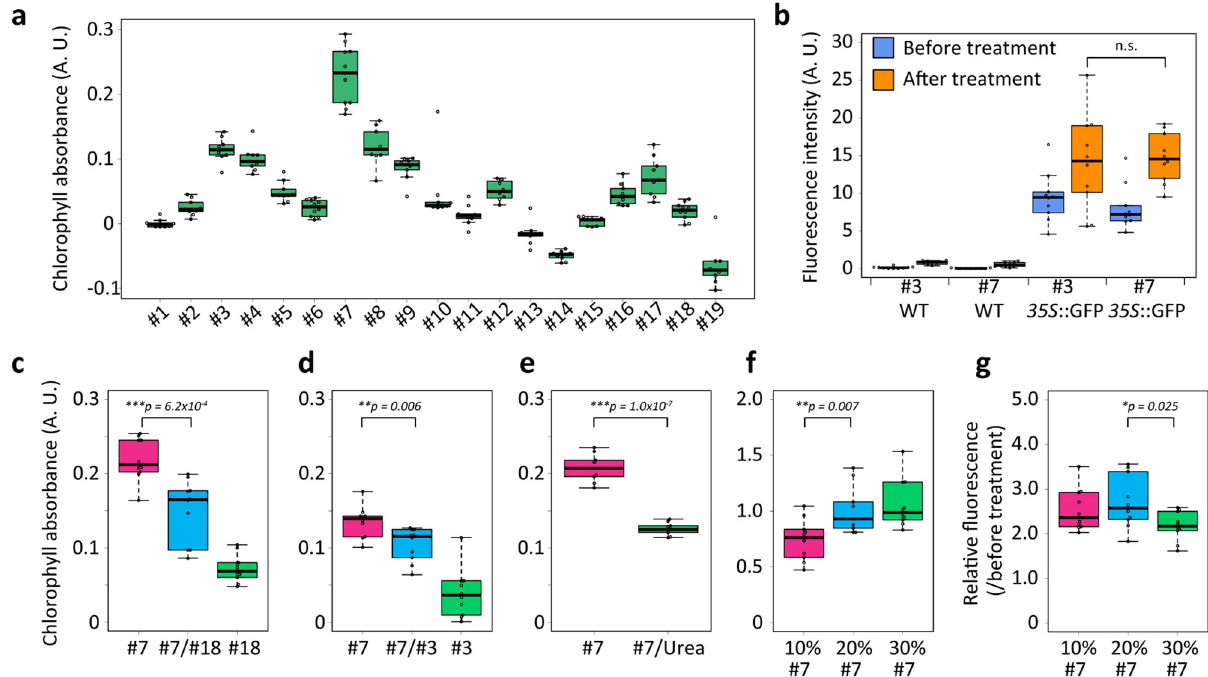
Fig. 1 Consideration of decolorization conditions. a Two-week-old plants were fi xed with 2% FA and then incubated in 10% (w/v) #1 to #19 detergent solutions (described in Supplementary Table 1) for 24 h. Chlorophyll absorbance in the detergent solutions was measured using an absorption spectrophotometer. The sample size was indicated in Supplementary Data 1. b Fluorescence intensity quanti fi ed from fl uorescence images of the wild type and plants expressing GFP before and after incubation in 10% (w/v) #3 and 10% (w/v) #7 solution. c – e Two-week-old plants were fi xed with 2% FA and then incubated in the solutions of 10% (w/v) #3, #7, and #18 and in the mixtures of 5% (w/v) #7 plus 5% (w/v) #18, 5% (w/v) #7 plus 5% (w/v) #3, and 10% (w/v) #7 plus 25% (w/v) urea for 24 h and then chlorophyll absorbance in the detergent solutions was measured. f Twenty-day-old plants were fi xed with 2% FA and then incubated in 10, 20, and 30% (w/v) #7 solution for 24 h. The chlorophyll absorbance in the detergent solutions was measured. g Relative fl uorescence intensity is calculated as fl uorescence intensity in the plant after treatment over that before treatment. The fl uorescence intensity was measured from fl uorescence images of plants expressing GFP before and after incubation in 10, 20, and 30% (w/v) #7 solution for 24 h. Statistical signi fi cance was evaluated using the two-sided Welch ’ s t -test. n = 9 plants ( e ) and 10 plants ( b , c , d , f , g